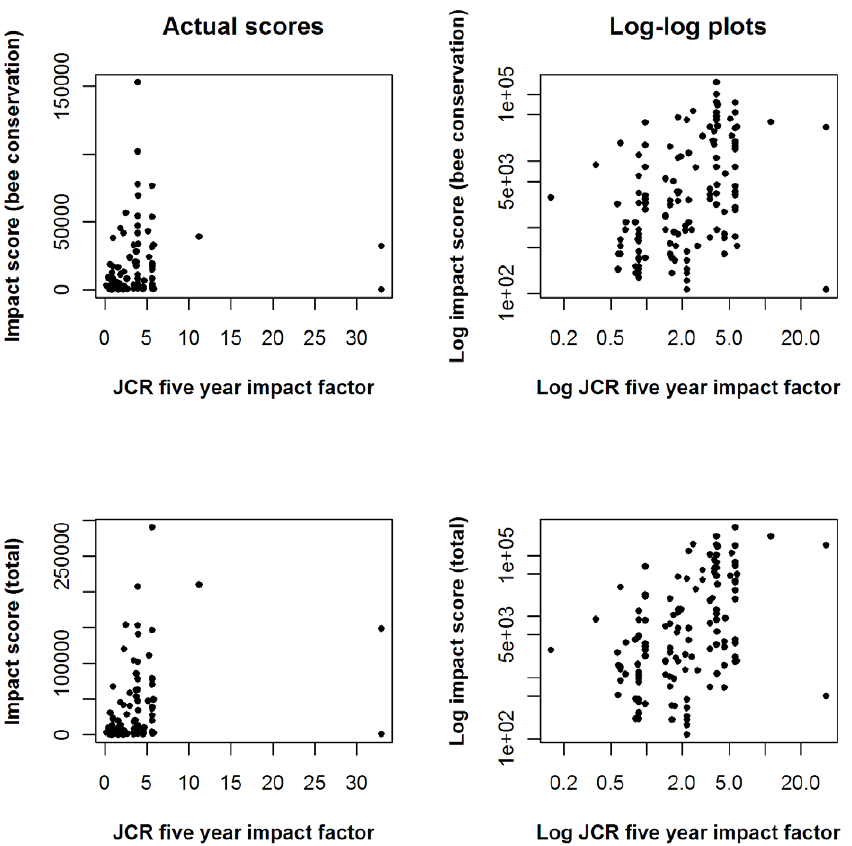
Figure 4. Impacts in bee conservation (top), and estimated total impacts (bottom), related to impact factor of publishing journal. These graphs include 135 publications published in journals for which impact factors are available. The log plots are presented to make the weak correlation easier to see. The publications in high impact journals with low impact scores are discussed in the text.